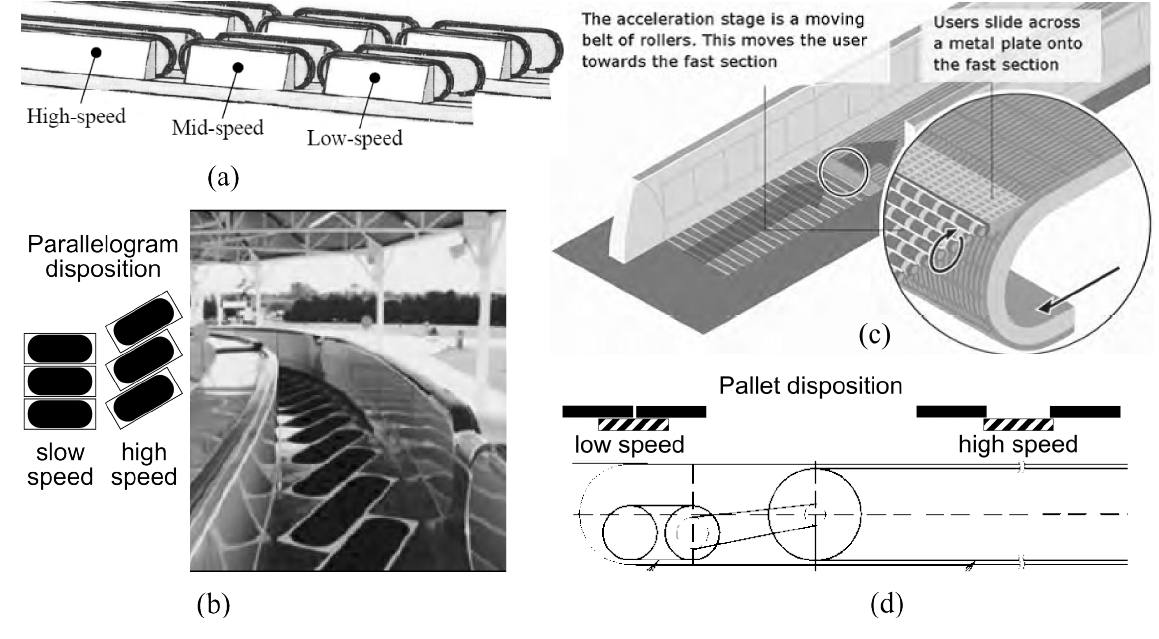
Figure 4. Accelerating moving walkway types. (a) in-line belts, adapted from Loder (1998). (b) sliding parallelograms, adapted from Todd (1974). (c) accelerating/decelerating rollers, adapted from Cote and Gempp (1998). (d) sliding pallets, adapted from Gonzalez Alemany and Cuello